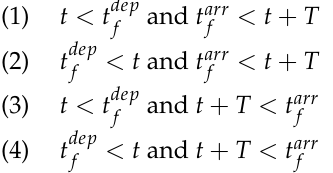
represent the departure airport and departure